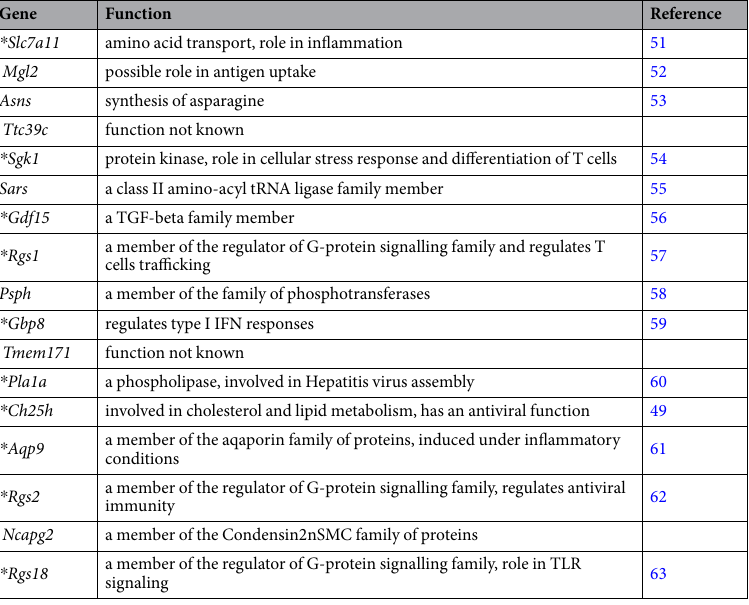
Table 2. Genes predicted to be regulated by ATF3. An in-house python program was written to analyze the published microarray and ChIP data 33, 34 to predict genes that may be regulated by ATF3. Known or predicted functions of the gene have been listed, and genes with a known role in either inflammation or antiviral immunity are marked with an asterisk.